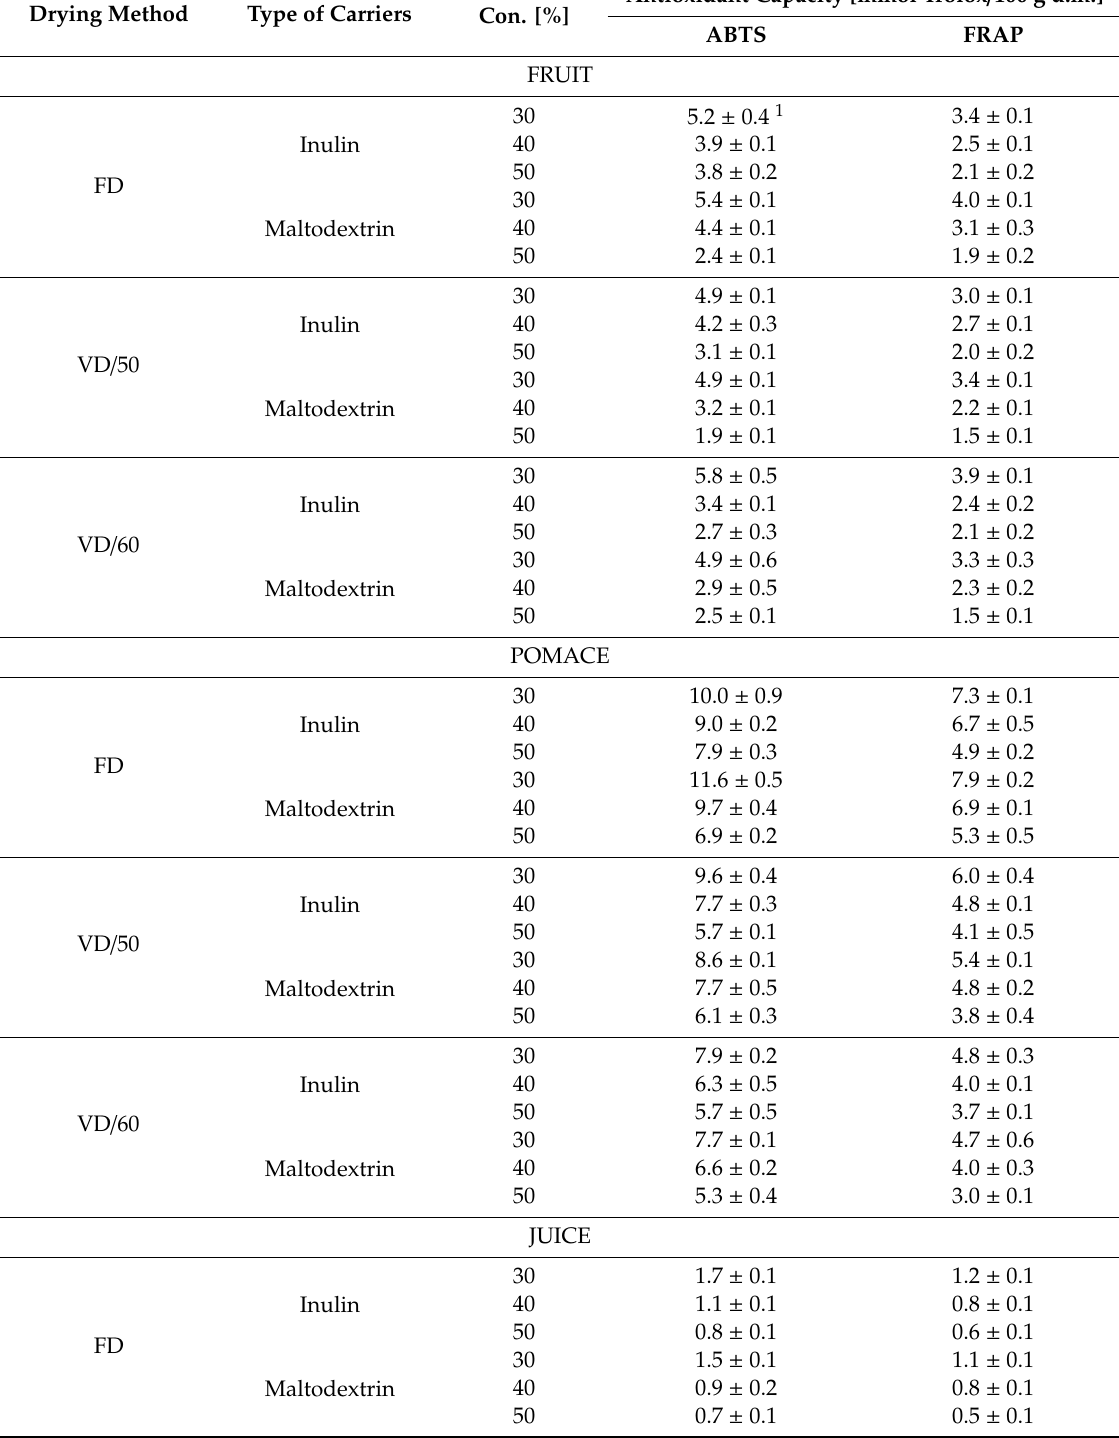
Table 2. Antioxidant activity [mmol Trolox / 100 g d.m.] of the fruit, juice, and pomace powders made from Saskatoon